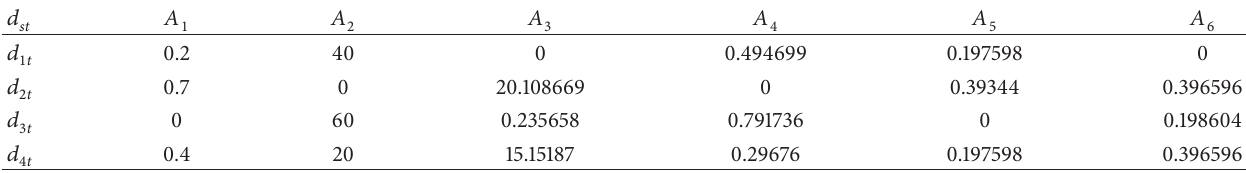
Table 5: Nearness degree of every index vector to its target center index vector.